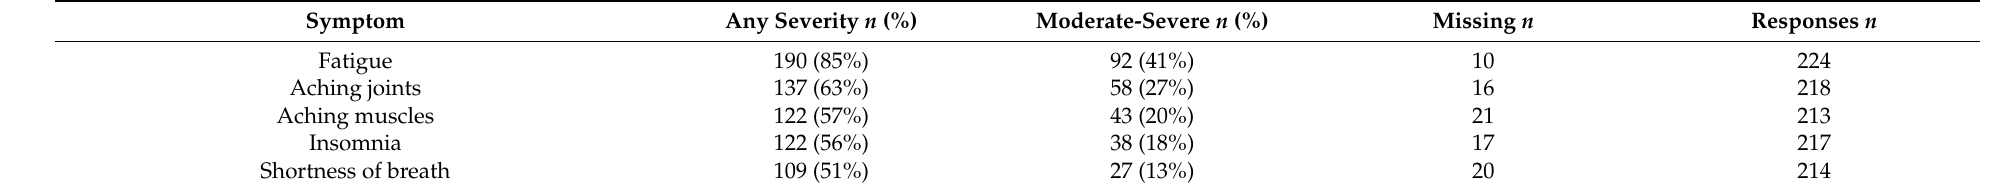
Table 2. Most common symptomatic immune-related adverse events (irAEs). Note: Some percentages do not equal 100 due to sporadic missing data. Any irAE was defined as patients reporting “a little bit,” “somewhat,” “quite a bit,” or “very much.” A moderate to severe irAE was defined as patients reporting “quite a bit” or “very